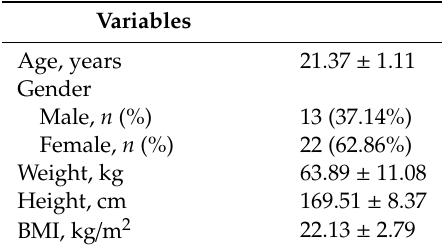
Table 1. Subjects’ demographic